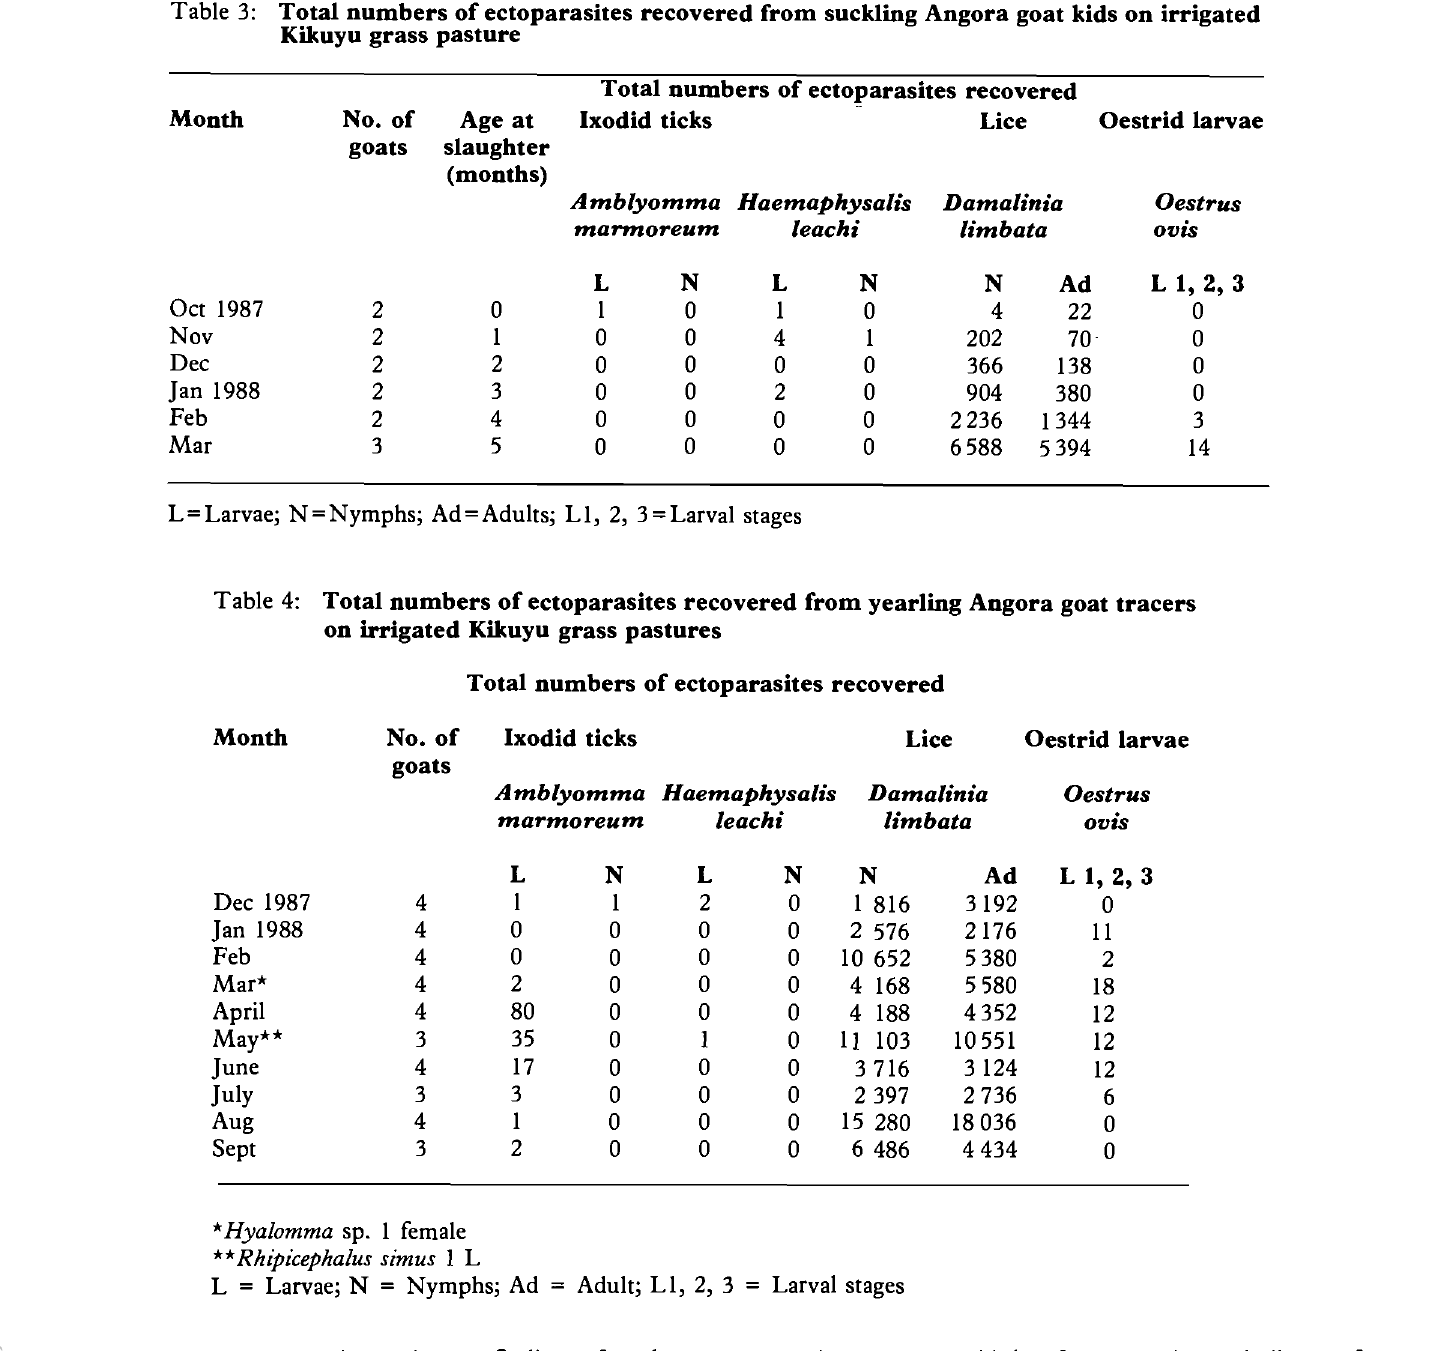
Table 4: Total numbers of ectoparasites recovered from yearling Angora goat tracers on irrigated Kikuyu grass pastures Total numbers of ectoparasites